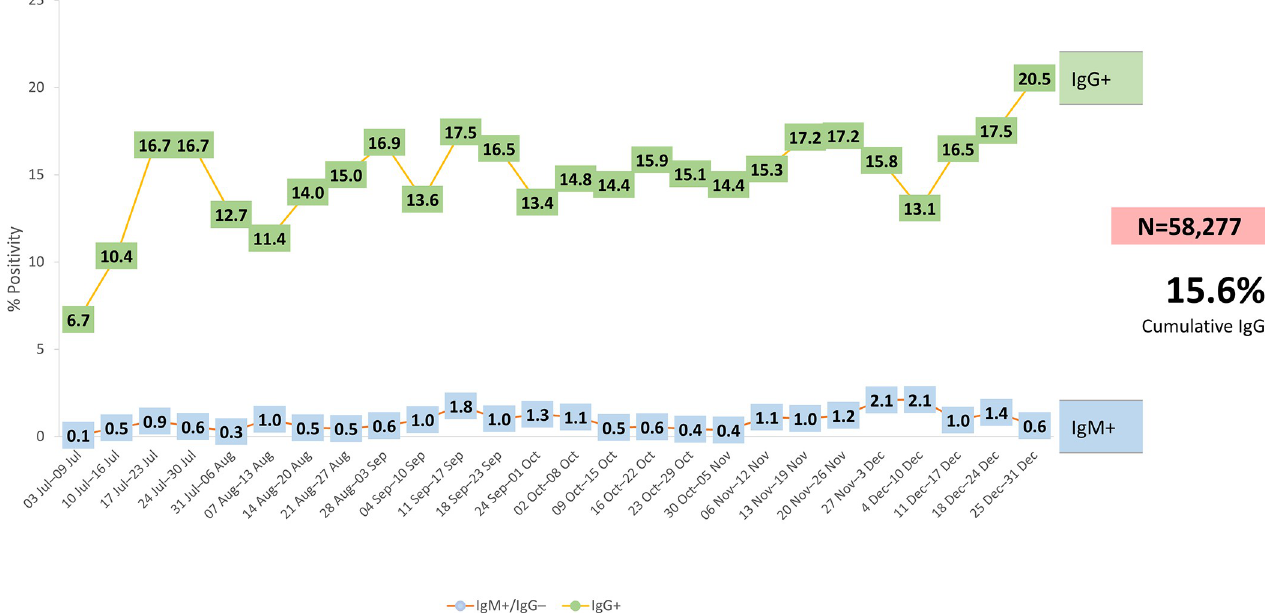
Fig 2. Weekly serological test positivity for SARS-CoV-2 by workplace testing (MIDO COVID; N = 58,277). Abbreviations: Ig, immunoglobulin; MIDO, Integrated Measurement for Early Detection.